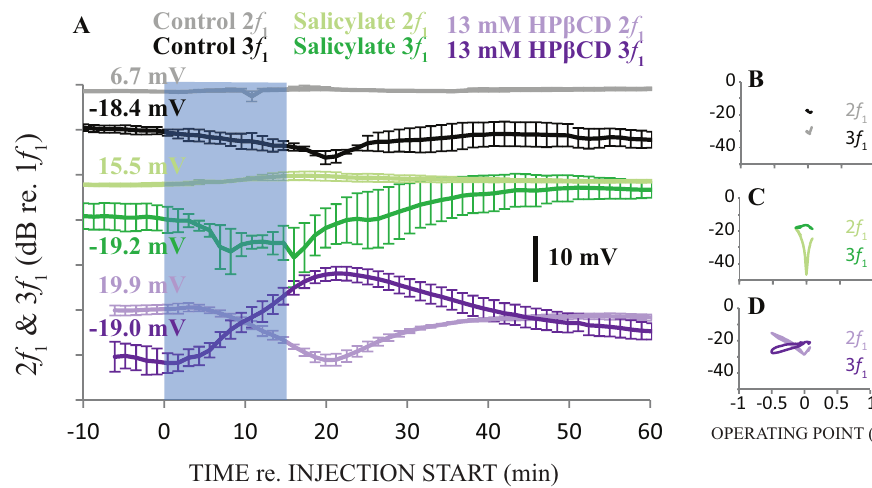
Fig 8. Panel A: Cochlearresponseharmonicsrecordedwith a round windowelectrodeto 90 dB SPL 500 Hz tone bursts. The semi-transparent blue rectangleidentifies the 15 minute durationof solutioninjectionsinto the cochlearapex. The ranking of measurements on the y-axis was determined by the effect of the solution on the amplitudeof 3 f 1 of the cochlearresponse,with the measurements associated with the smallest effect at the top of the figure progressingto the largest effect at the bottom of the figure. N = 3 for each treatment. PanelsB-D: Even and odd order harmonic amplitudemeasurements expressedas a function of operating point estimates nonlinearities involvedwith transferringacoustic soundinto neuralexcitation( f TR ). Even and odd order distortions from exemplarears in the control and salicylategroups follow trajectoriesof the second and third derivative of a function that can describe f TR and are consistent with previousexperiments that injectedgel into the cochlearapex to cause sustaineddisplacement of the organ of Corti (Panels B&C). Effects from 13 mM HP β CDare unprecedented and cannot be explainedby sustaineddisplacement of the organ of Corti or apparentOHC loss (Fig 6C and Fig 6B), but the marked changeoperatingpoint estimates inform the interpretation of affects f TR are the likely origin of dramatic changesto DPOAE amplitude measurements (Fig